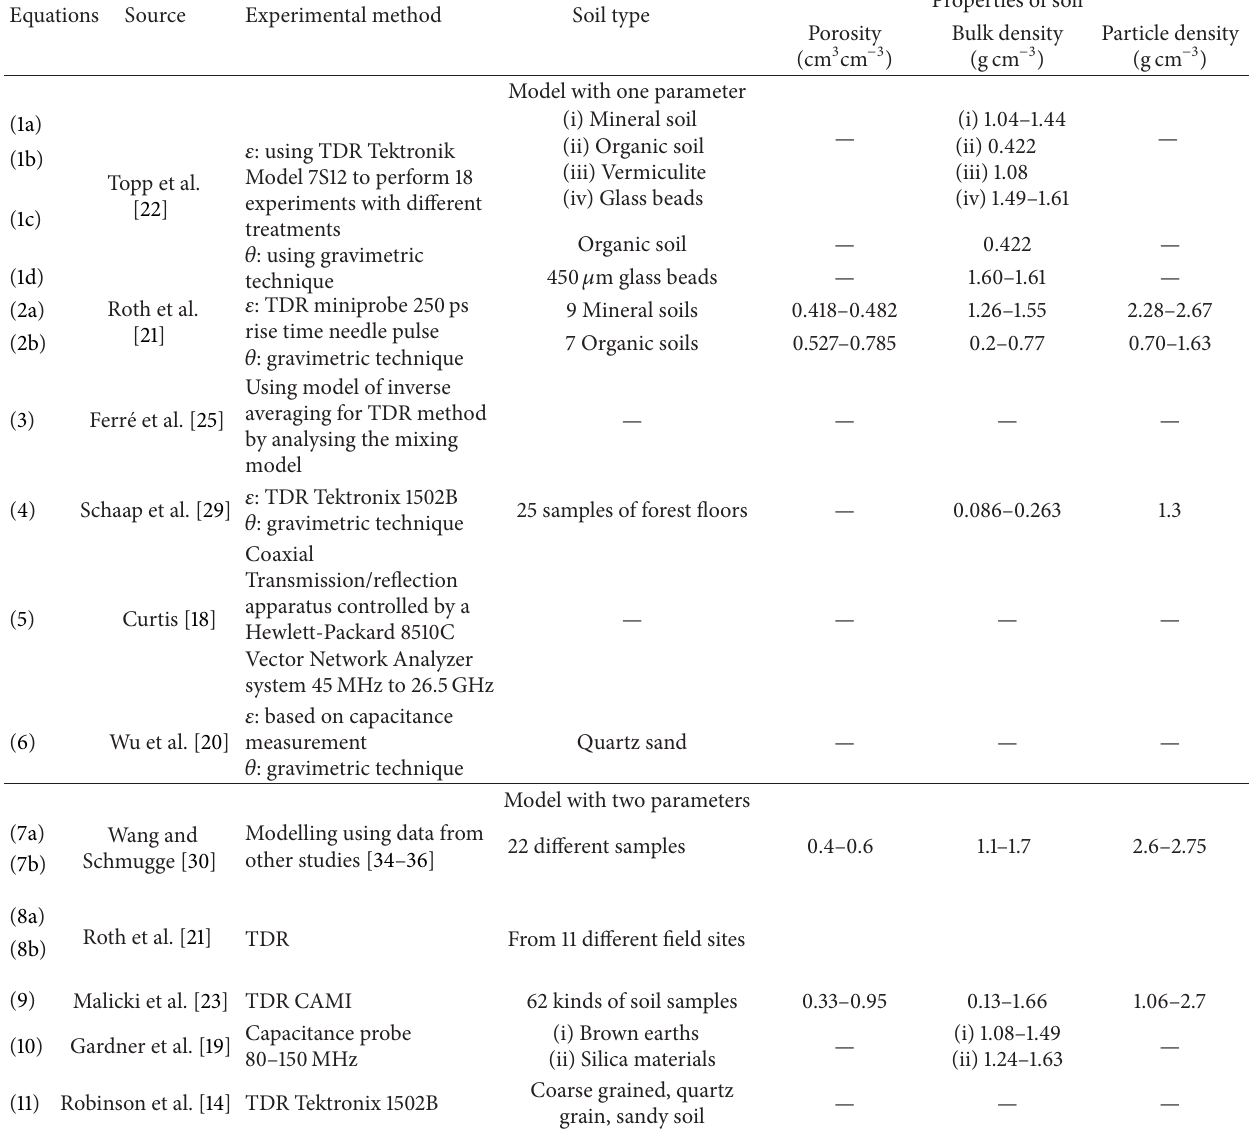
Table 1: Summary of all equations of 𝜀 - 𝜃